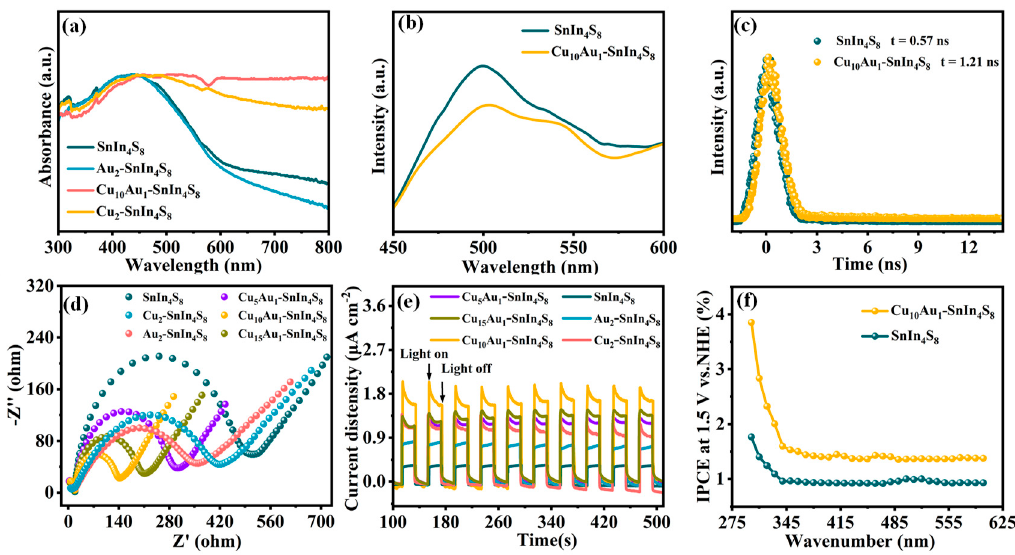
Figure 5. ( a ) UV-vis DRS spectra, ( b ) PL spectra, ( c ) TRPL spectra, ( d ) EIS and ( e ) transient photocurrent responses ( f ) IPCE of the photocatalysts.